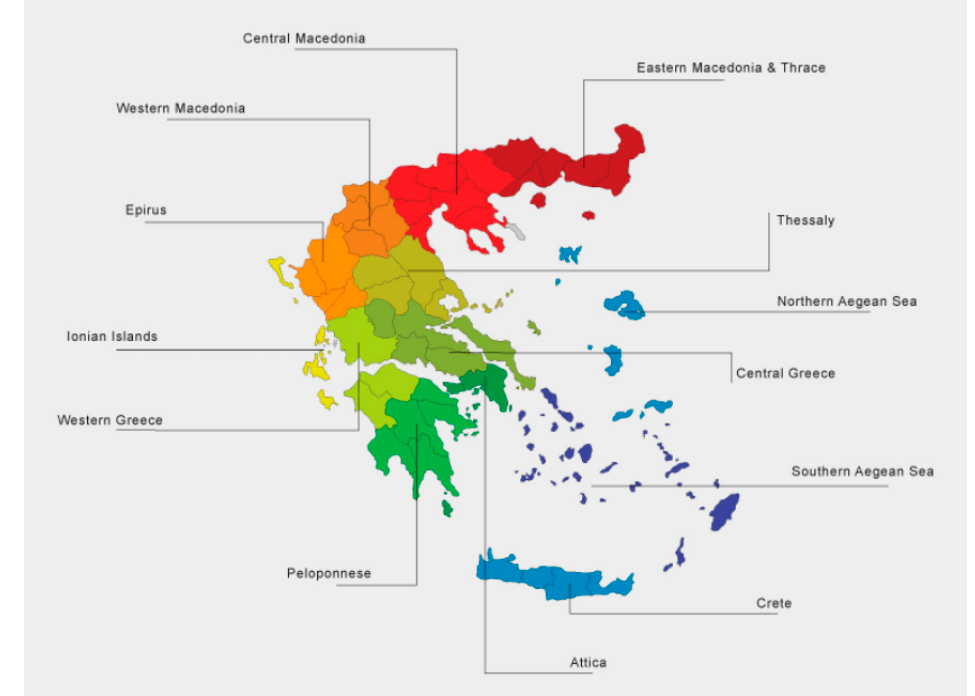
Figure A1. Map of Greece’s 13 administrative districts. Table A1. SHARE COVID-19 survey respondents’ geographical distribution.